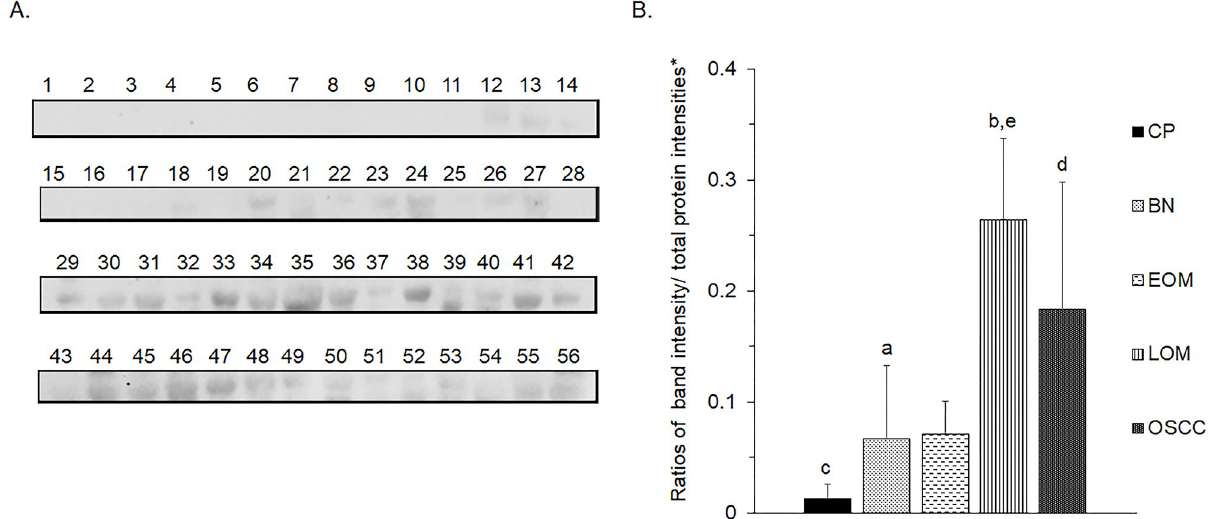
Fig 14. Western blot analysis of nuclear factor kappa B (NF- κ B) of individual saliva samples from dogs with benign oral tumors (BN), early- and late-stage oral melanoma (EOM and LOM, respectively), oral squamous cell carcinoma (OSCC) and periodontitis and normal controls (CP). Representative western blot for NF- κ B at 65 kDa (A) and bar graph of ratios of NF- κ B protein intensity to total blotted proteins in each lane in the first half of a membrane � (B) . a–b, c-d and c-e denote a significant difference at p < 0.05, p < 0.01 and p < 0.001, respectively.